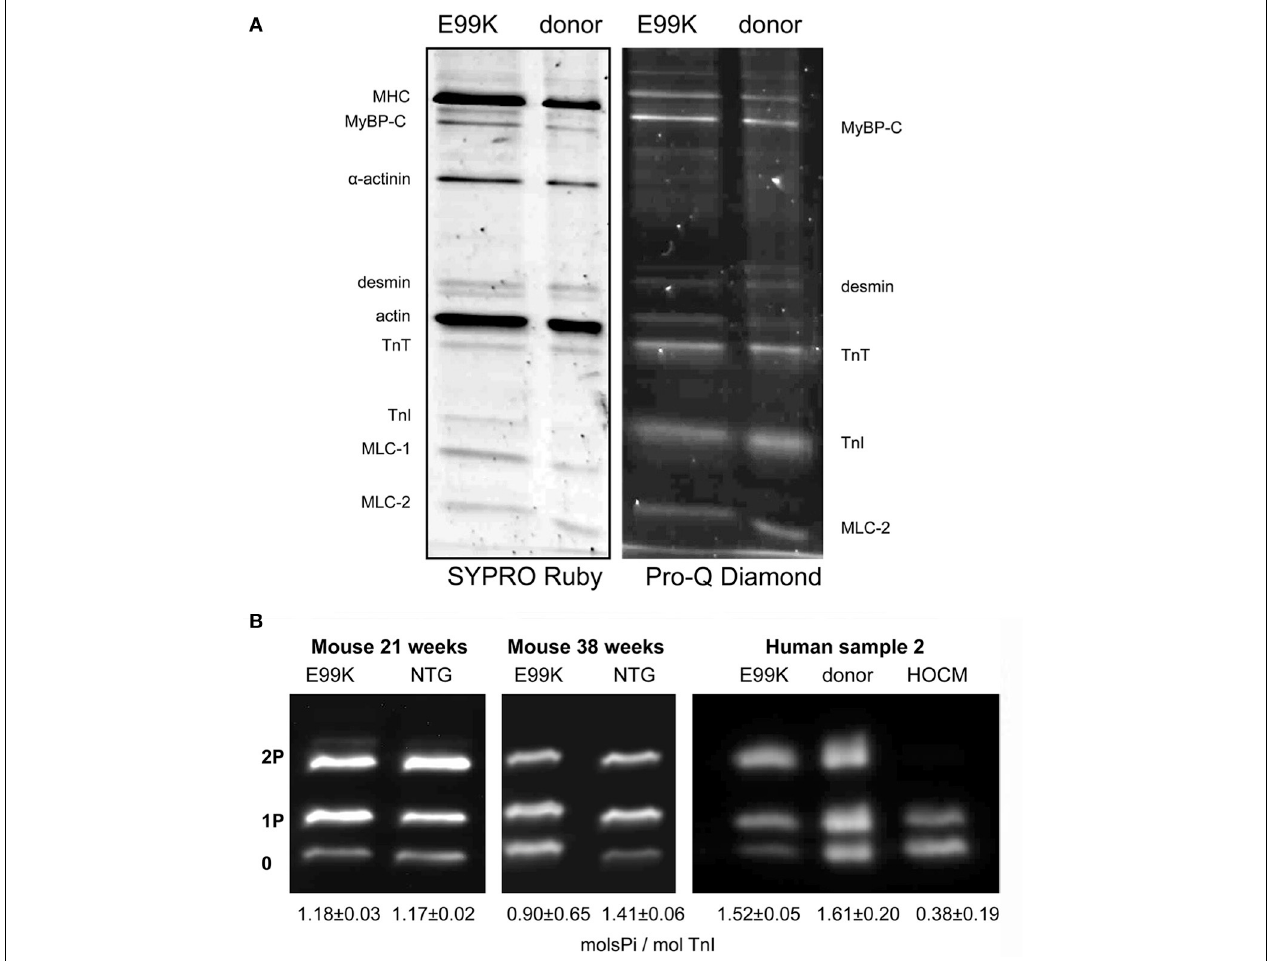
FIGURE 1 | SDS-PAGE analysis of myofibrillar proteins and phosphoproteins. (A) Myofibril fraction of heart muscle separated by SDS-PAGE and stained successively with Pro-Q Diamond phosphoprotein stain and SYPRO Ruby total protein stain. Left, NTG and ACTC E99K mouse heart myofibrils (38 weeks male). Right, donor and ACTC E99K heart sample 2 myofibrils (Song et al., 2011). The TnI band is strongly stained together with MyBP-C, TnT and MLC-2. (B) Phosphate affinity